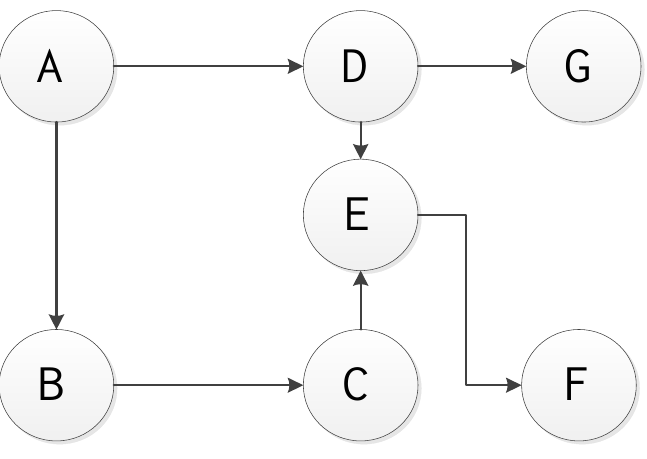
Table 1. Component number.